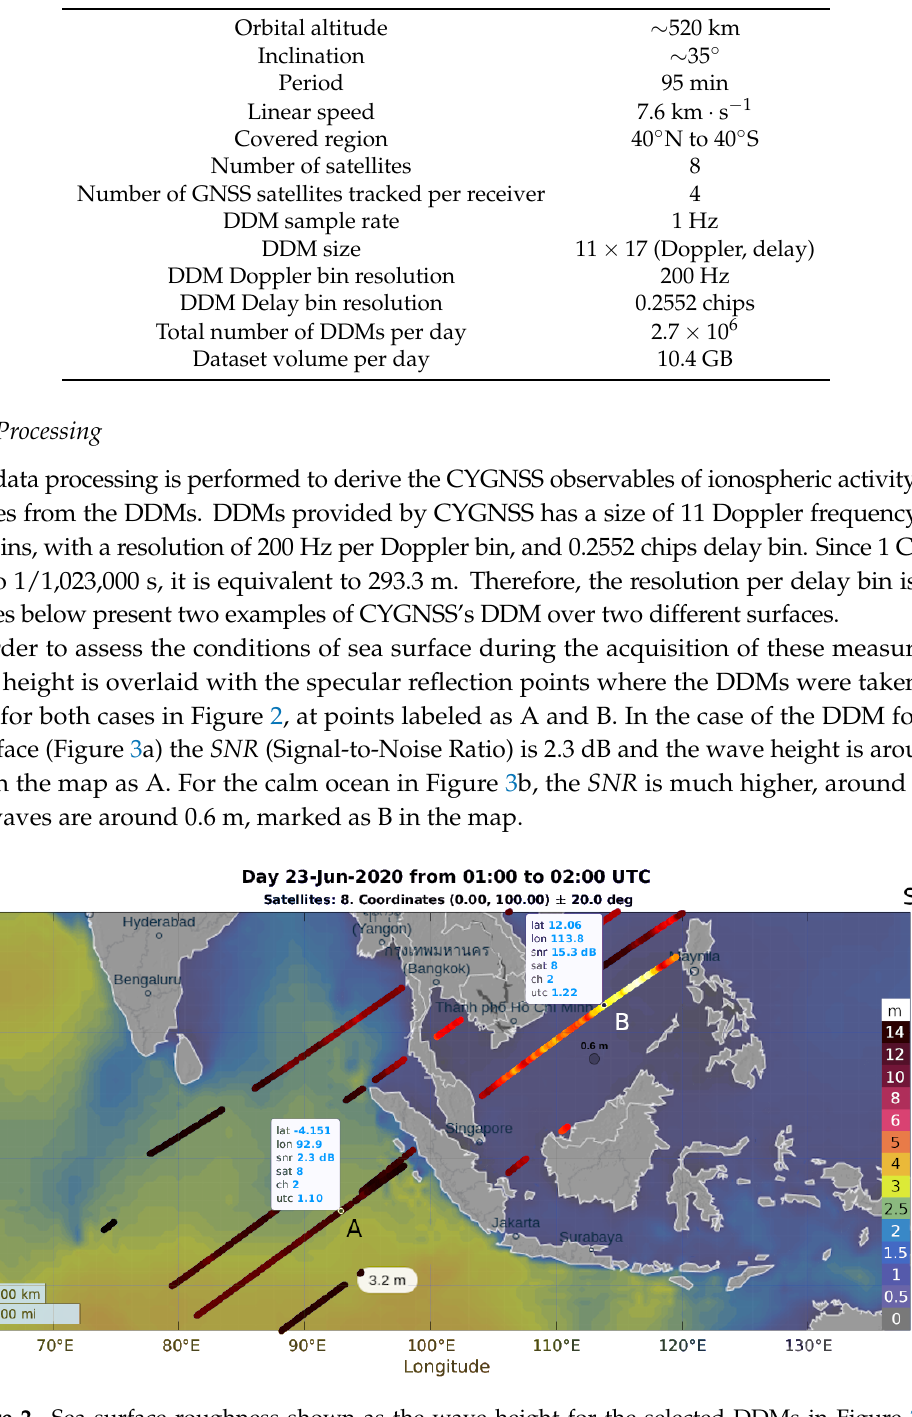
Figure 2. Sea surface roughness shown as the wave height for the selected DDMs in Figure 3 is underlaid the SNR (Signal-to-Noise Ratio) values (in dB) for some samples around the exact coordinates of the DDM, marked with labels A and B,